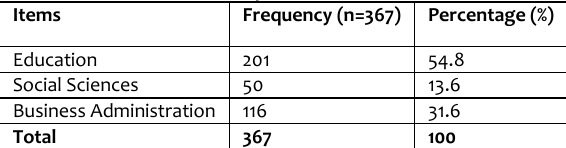
Table 4: Distribution of Respondents Based on their Faculties Items